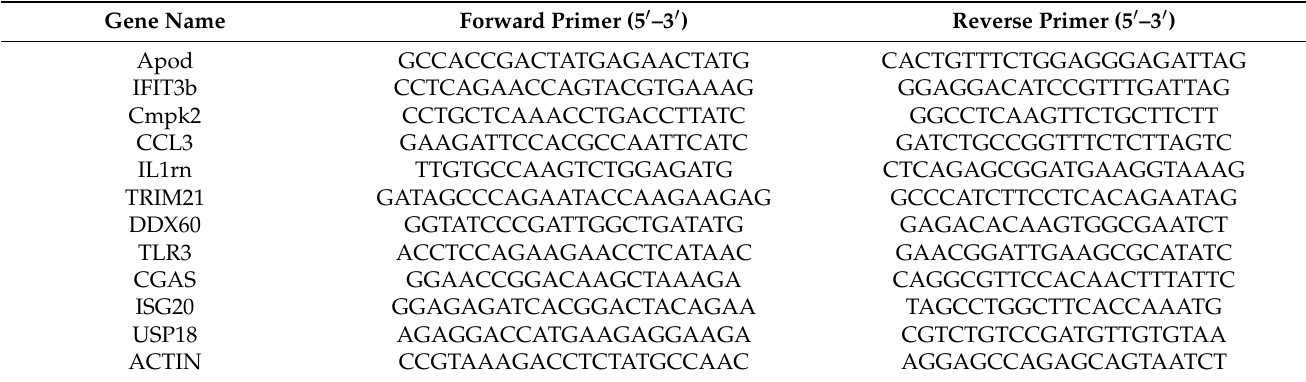
Table 1. Primer sequences that were used for the RT-qPCR.